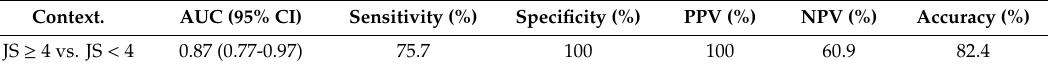
Table 2. Performance parameters for XIST demethylated fragment in discriminating distinct Johnsen’s score